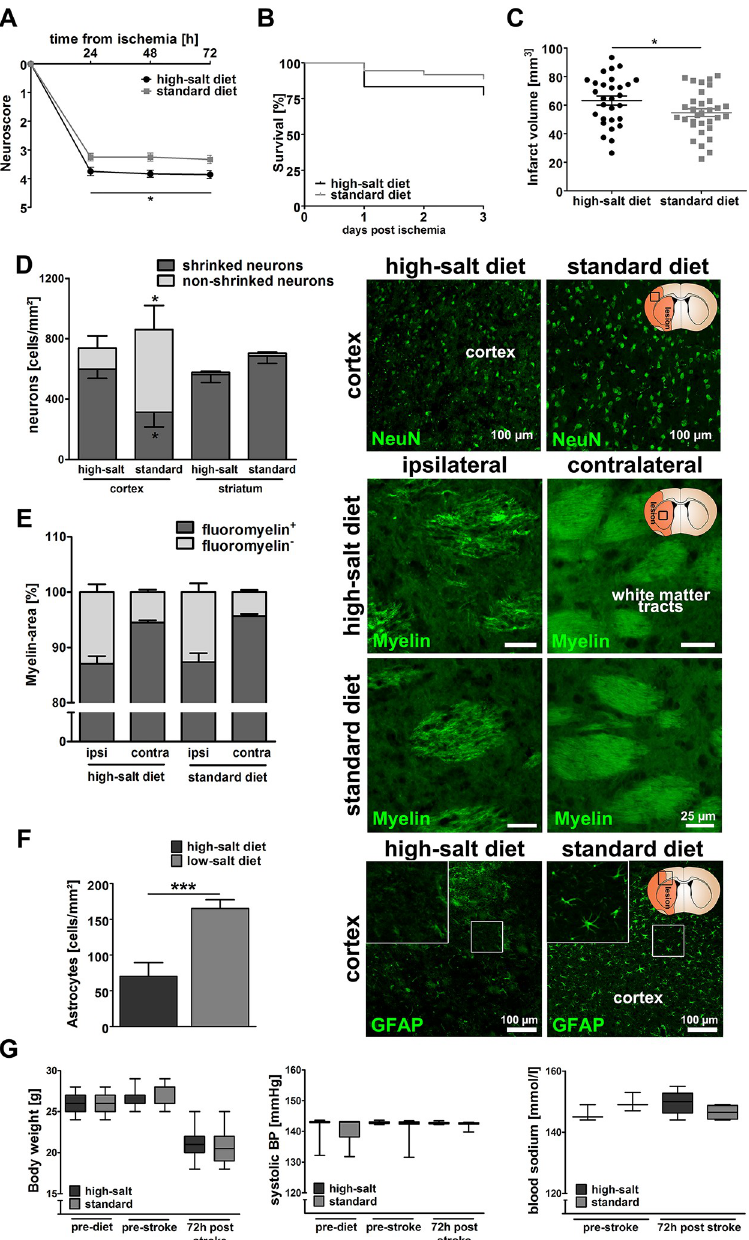
Fig 1. Sodium chloride aggravates functional and structural outcomes after ischemic stroke. (A) Neurological deficit score assessment showed significantly worse functional outcomes following high-salt diet (p < 0.05, 2way ANOVA, n = 36 per group). (B) Mortality rates did not significantly differ between both groups (p = 0.19, Log-rank (Mantel-Cox) Test, n = 36 per group). (C) Infarct volumes were significantly increased after high-salt diet (64.2 mm 2 ± 3.1 mm 2 vs. 54.7 mm 2 ± 2.7 mm 2 , p < 0.05, t-test, n = 28 to 31 per group). (D) Immunohistochemical analyses revealed a significant increase in the number of shrinked cortical neurons following high-salt diet, and vice versa a reduced number of intact cortical neurons (p < 0.05, t-test, n = 8 to 11 per group). NeuN-staining was used to visualize intact and shrinked neurons. (E) The extent of fluoromyelin-positive myelin areas was similar in both groups (p = 0.88, t-test, n = 20 to 22 per group) Fluoromyelin-staining was employed to visualize white matter tracts in the ispilateral and contralateral hemisphere of both groups. (F) High-salt diet induced a significant loss of GFAP + -astrocytes in the periinfarct region (p < 0.001, t-test, n = 10 to 11 per group). (G) Body weight and systolic blood pressure were not significantly influenced (p = 0.95 and p = 0.83 2way ANOVA, n = 36 per group). Blood sodium levels did not significantly differ between both groups prior to MCAO and three days after MCAO (p = 0.19 and p = 0.18, t-test, n = 3 to 6 per group).